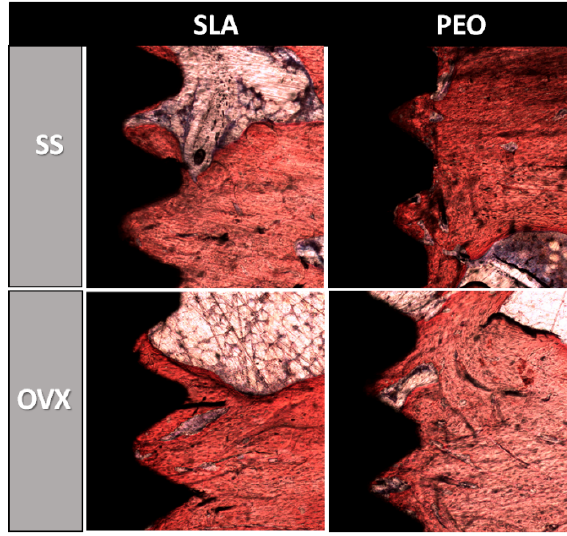
Figure 8. Histology staining in calcium matrix by alizarin red and Stevenel blue showing peri-implant bone for SLA and PEO surface coating in each bone condition (SS and OVX) at 60 days. Original magnification ×10.